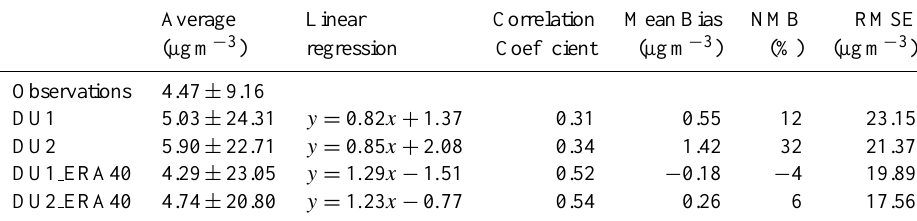
Table 8. Statistics of the monthly average dust concentrations. January has been excluded.